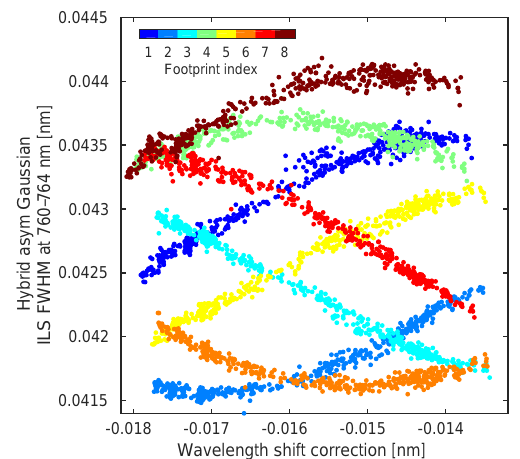
Figure 9. Correlation between the derived ILS FWHM using hybrid asymmetric function and the wavelength shift of each footprint for fitting window 1 at O2A band